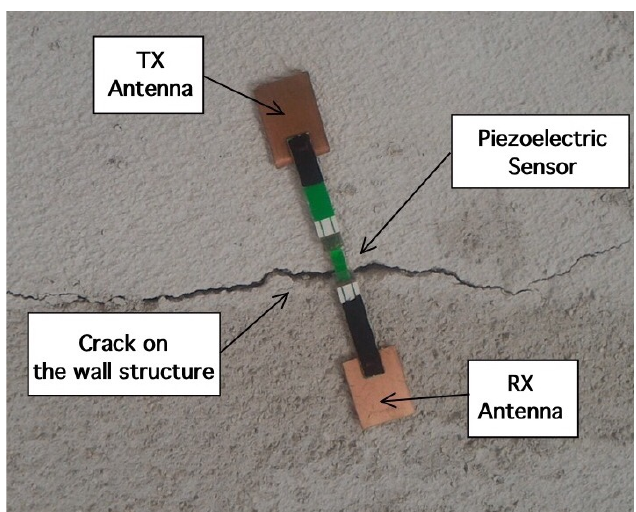
Figure 9. Photo of the crack and the tag placed on position A West side of the building.